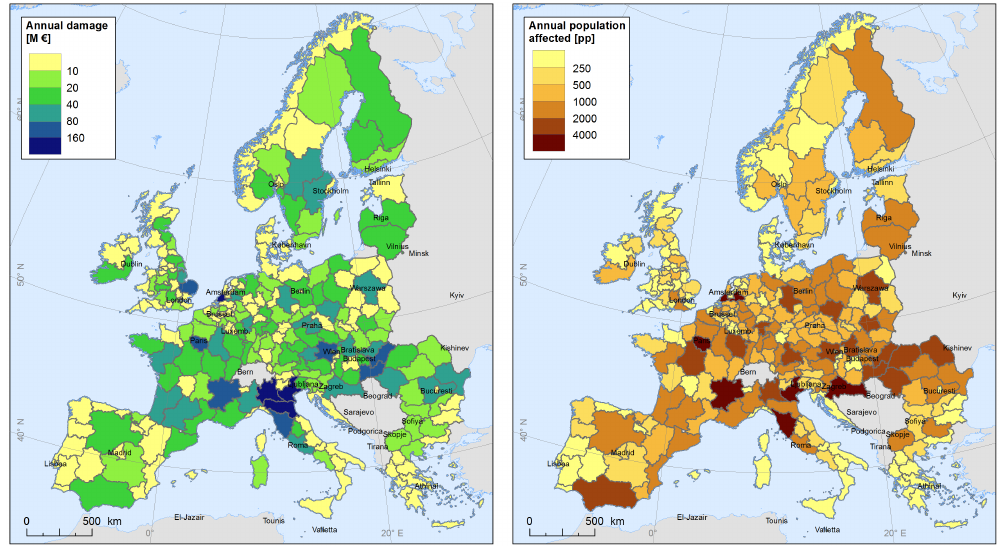
Figure 4. Mean annual damage and population affected at NUTS 2 level estimated through the integral method. Areas outside the simulation domain are masked in